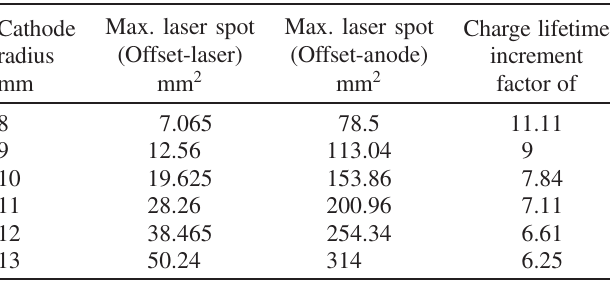
TABLE I. Comparison of maximum laser spot sizes for offset- laser and offset-anode operation and expected charge lifetime increment factor.